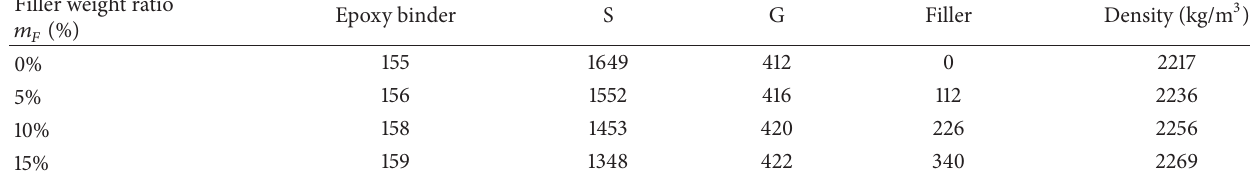
Table 2: The mix proportions in kg/m 3 of the modified polymer microconcrete formulated with 7% polymer of the total weight of the mortar. Filler weight ratio 𝑚 𝐹 (%)